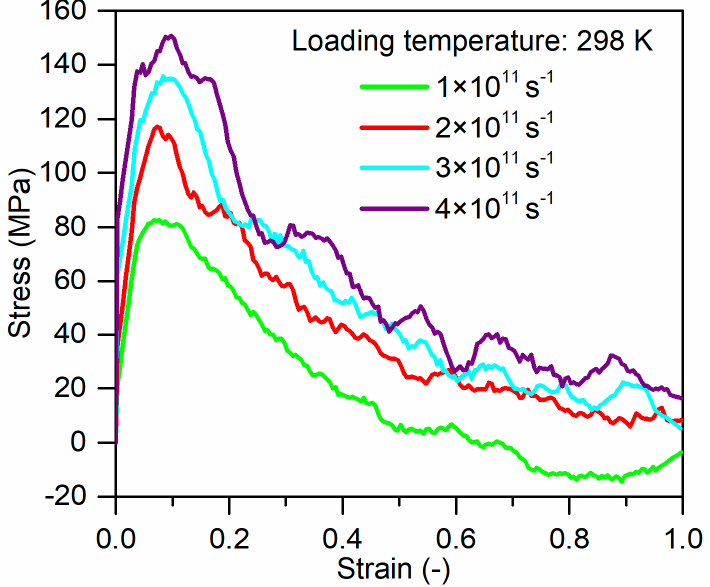
Figure 7. Tensile stress–strain curves of glass fiber/PP composites at different strain rates.